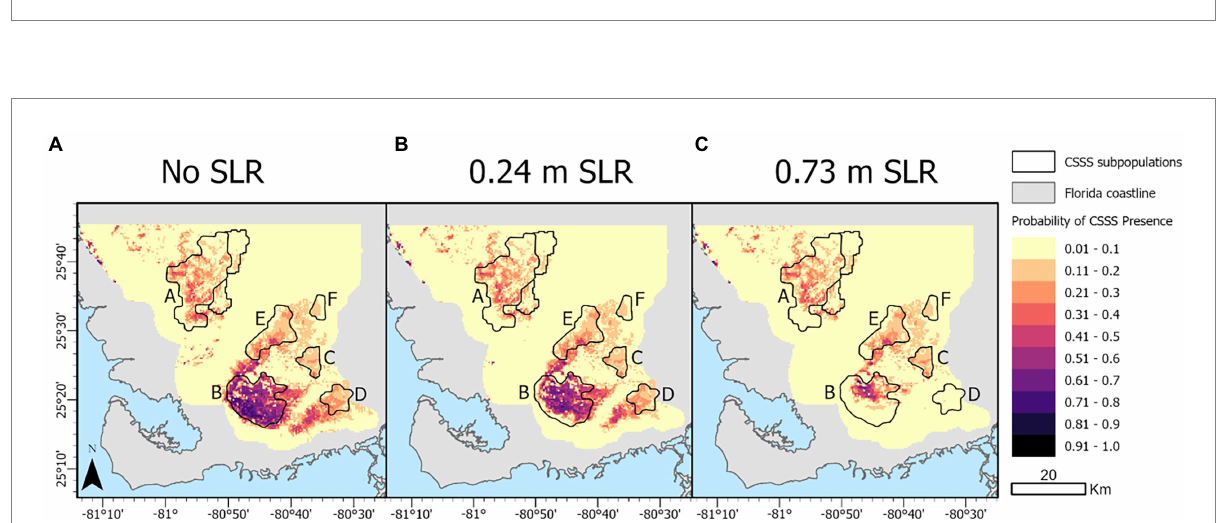
FIGURE 2 Boxplot showing the EverSparrow mean probability of presence for the Cape Sable seaside sparrow ( Ammospiza maritima mirabilis ) for the areas of subpopulations A, B, and D for three hydrologic scenarios: a baseline (NA22f) without sea level rise (SLR), the U.S. Army Corps of Engineers (USACE) intermediate SLR scenario (0.24 m in 50 years), and the USACE high SLR scenario (0.73 m in 50 years). Mean probability of presence values were averaged over the breeding season (March–June).